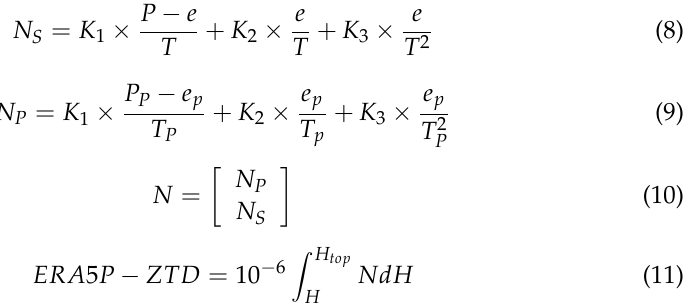
Calculating ERA5P-ZTD by the integral method. The ERA5P-ZTD values of the IGS stations are obtained by integrating as shown in the following equations [4].